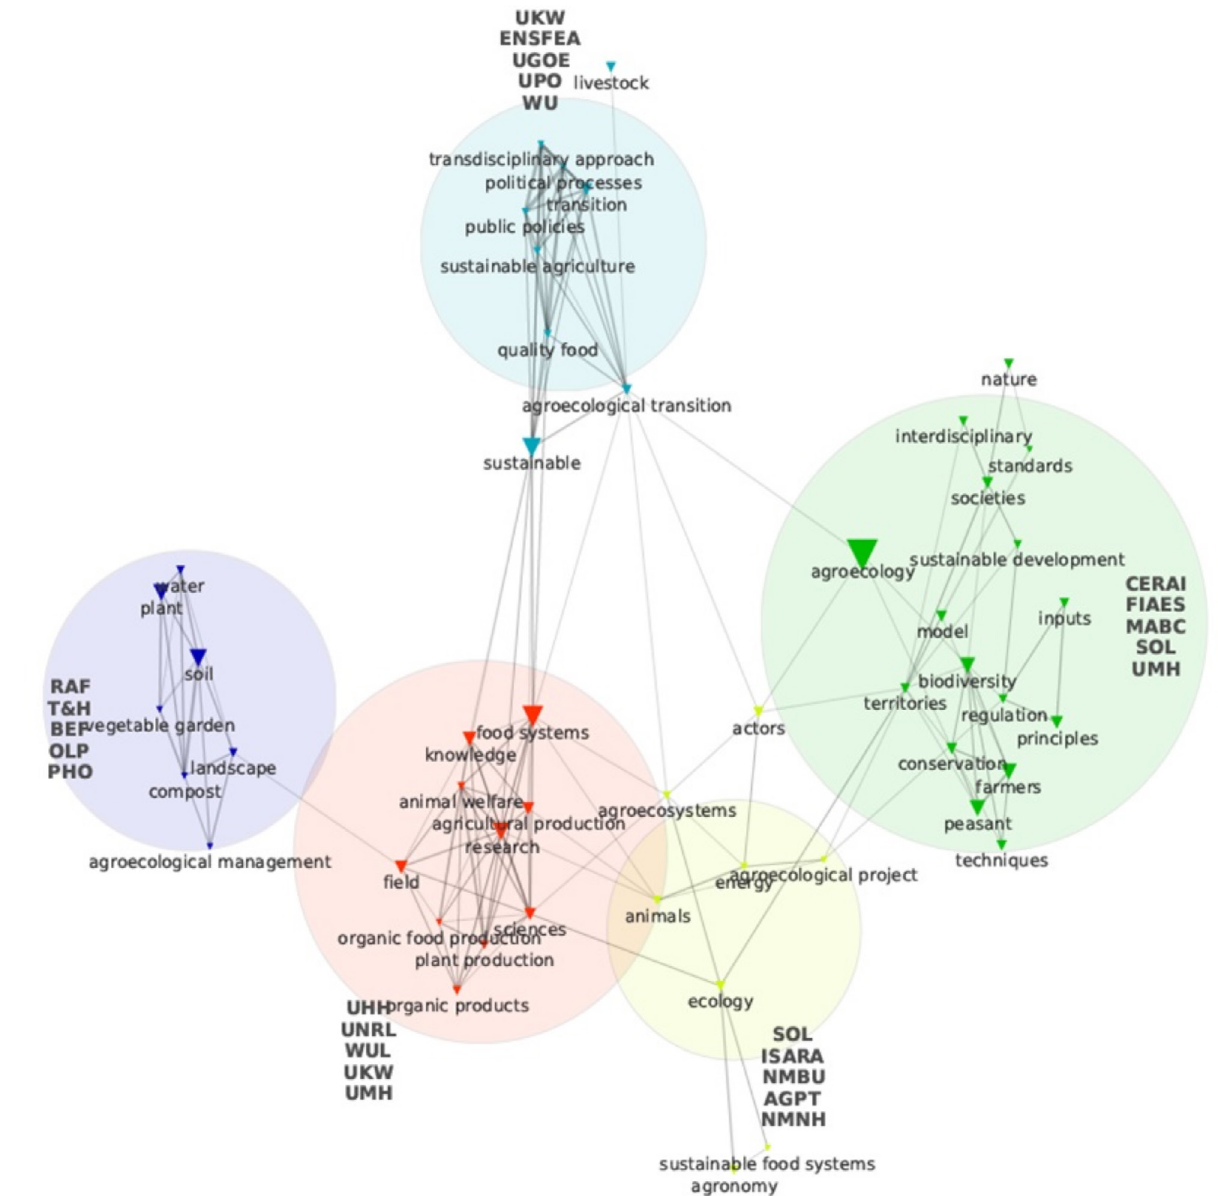
Figure 8: Representation of semantic spheres of co-occurrence and their most associated actors (based on the analysis of titles and descrip- tions of training